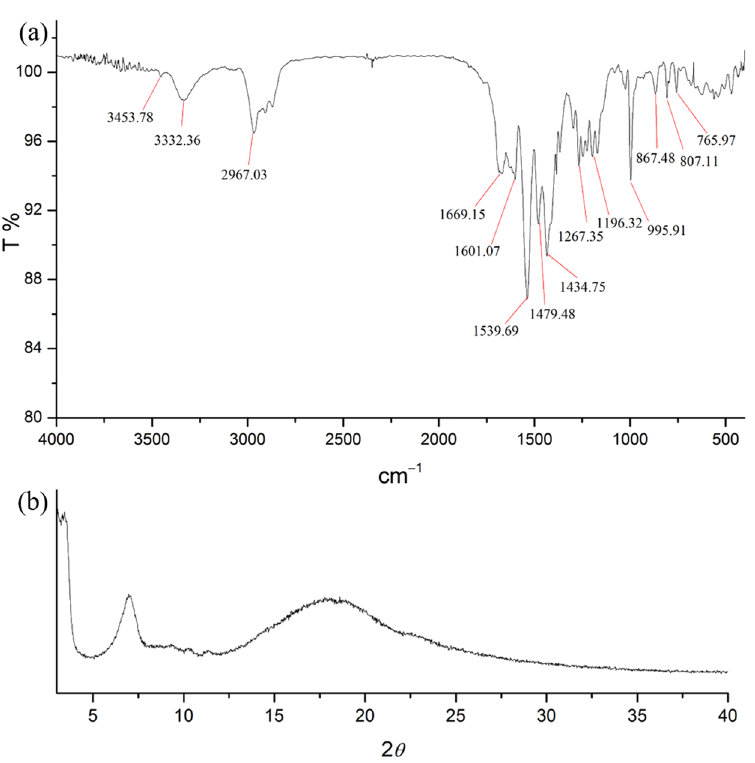
Figure 9. The FT-IR spectrum ( a ) and powder-XRD pattern ( b ) of bulk ( t - Bu - G 1 N ) 2